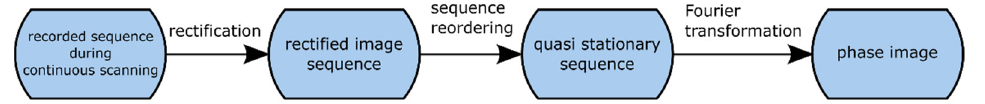
( a ) ( b ) Figure 11. ( a ) IR image of the squat defect during scanning, inductor is visible on the left side; ( b ) image after applied rectification transformation. In the next step, this transformed IR sequence is reorganized with the same method as described in an earlier publication [11]. The pixel-columns are shifted and interpolated according to the scanning speed and the camera’s FOV. In this way, a new image sequence is calculated where each pixel corresponds to a real position on the specimen’s surface. s, the shift of the specimen between two consecutive images of the rectified image sequence, is calculated as follows:  = ∙̅  , (1) where  is the motion speed in mm/s,  is the camera’s frame rate in Hz and ̅ is the spatial resolution of the transformed image in px/mm. In the case of measurements with the cooled infrared camera with a 300 Hz frame rate, the resolution ̅ is 5 px/mm. For the scan with a speed of 200 mm/s, this results in a shift s of 3.3 pixels between the consecutive images. Figure 12 shows one temperature image of the sequence after re-ordering the film sequence, i.e., after the scanning motion is eliminated. This quasi-static sequence is now evaluated to a phase image using Fourier transformation (see Figure 13). In this phase image, both large squat defects and also small shallow cracks in a line with the squats can be recognized, proving the advantages of using a phase image instead of one single tem- perature image for defect detection. Figure 12. Temperature image of the specimen after re-organizing the pixel-columns.